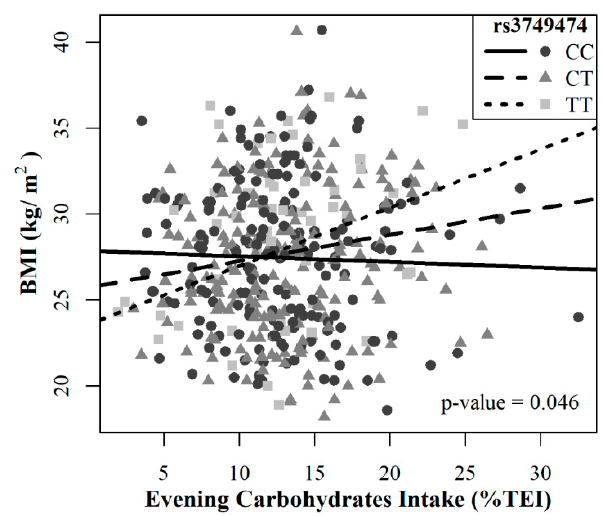
Figure 1. Association between the evening carbohydrates intake as a percentage of Total Daily Energy Intake (TEI) and the body mass index (BMI) according to the presence of the rs3749474. Participants carrying TT and CT genotype showed a positive association between the evening carbohydrate intake (%TEI) and the BMI ( β = 0.3379, 95% CI = (0.1689,0.5080)) and ( β = 0.1529, 95% CI = ( − 0.0164,0.3227)) respectively, whereas the common homozygous (CC) showed a negative association ( β = − 0.0321, 95% CI = ( − 0.1505,0.0862)) (adjusted p = 0.046).